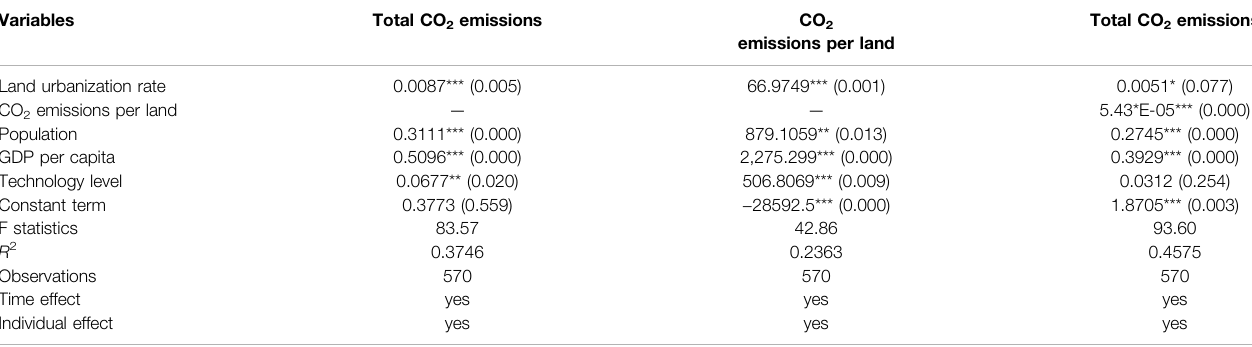
TABLE 7 | The mediating effect of CO 2 emissions per land.